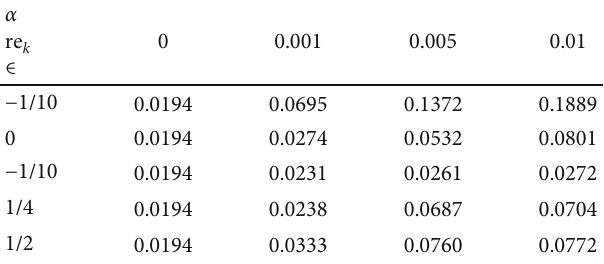
ff erent noise levels ϵ and index Table 3: The relative error re k with di of penalty term γ for α = ð 0 : 9,0 : 5,0 : 2 Þ in Example